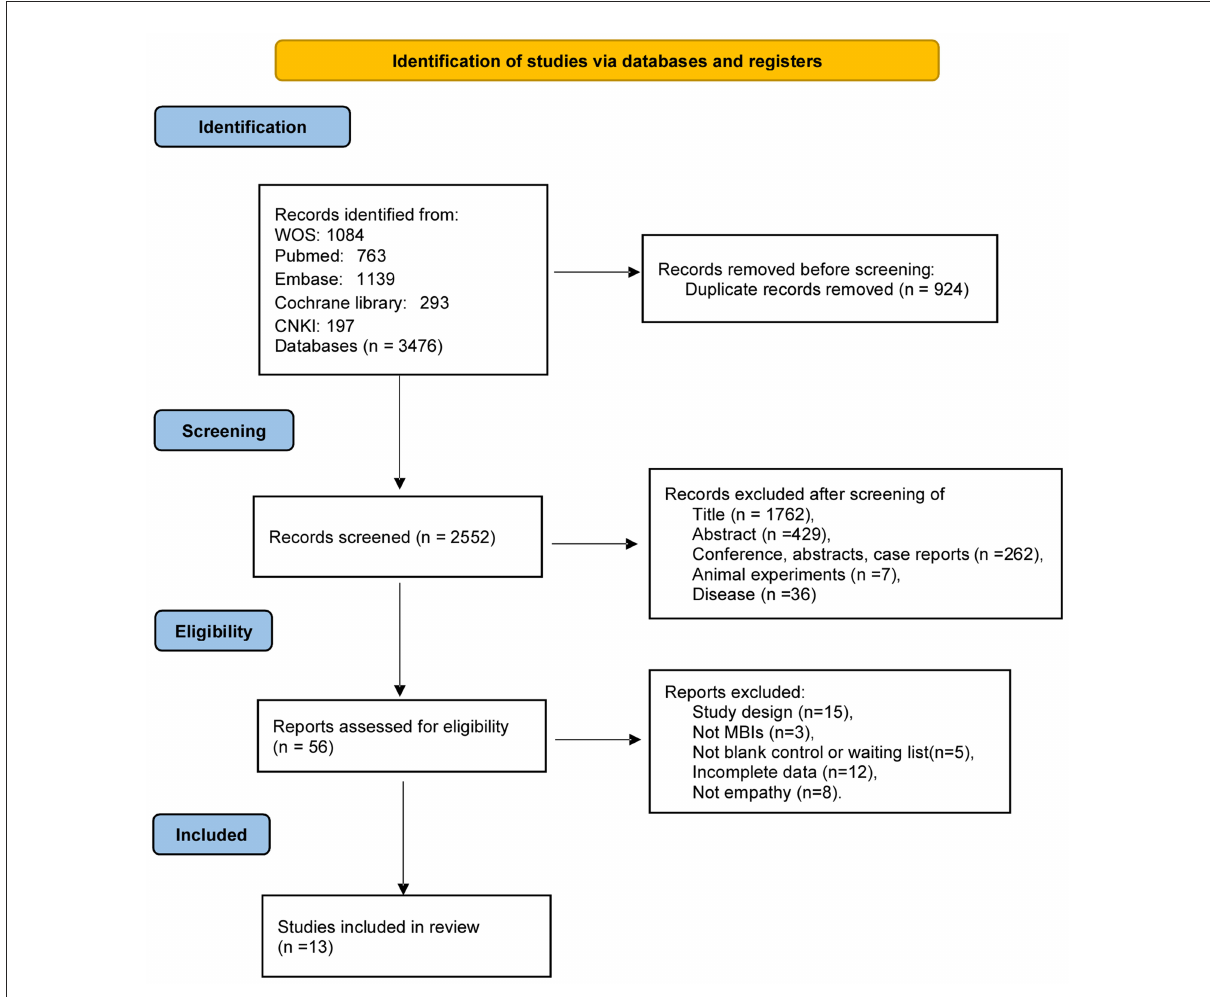
FIGURE1 PRISMA flow chart of study